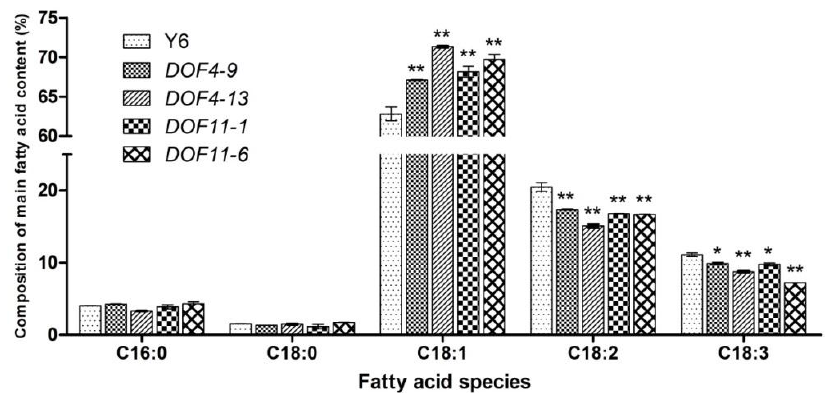
Figure 2. Composition of the major fatty acids in GmDof4 and GmDof11 transgenic seeds. The data represent the means ± SD of three replicate experiments and were analyzed by Student’s t -test ( n = 3). * p < 0.05; ** p < 0.01.